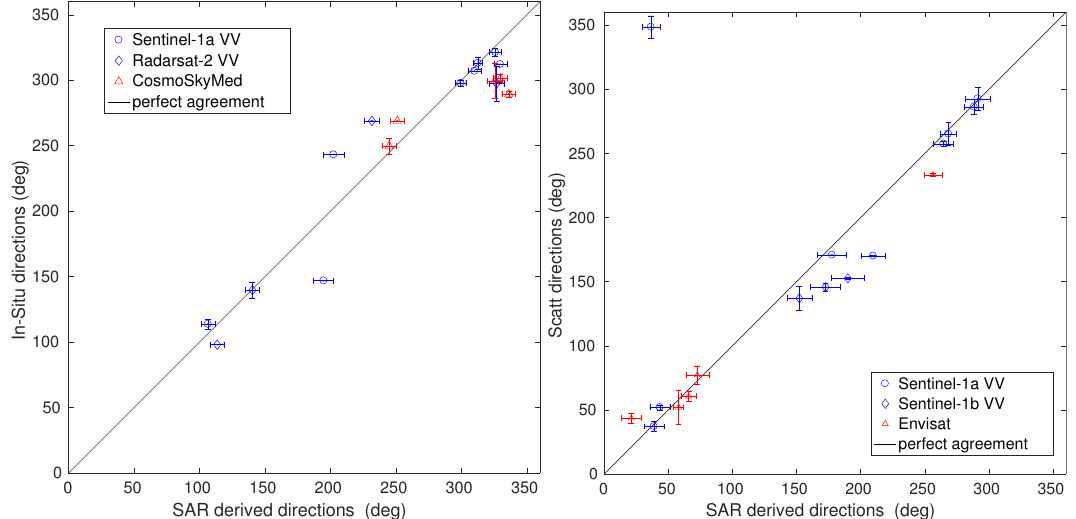
Figure 6. Comparison between SAR derived, in situ and scatterometer wind directions. Left panel : SAR versus in situ wind directions for the Oristano Gulf area. Right panel : SAR derived versus scatterometer wind directions. The bars report the standard deviations. Solid line: perfect